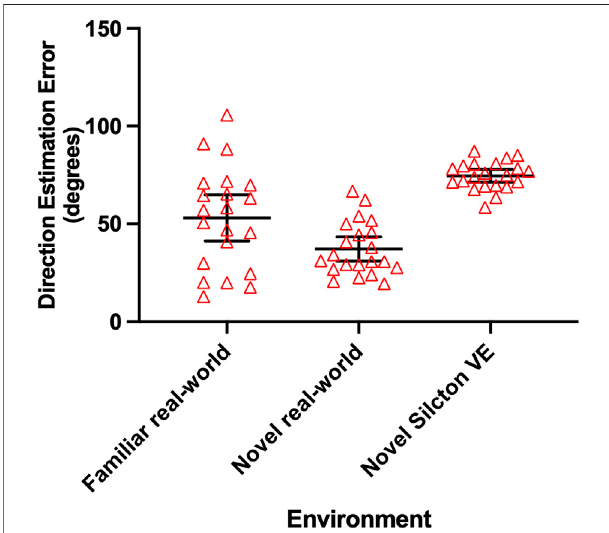
FIGURE 5 | Direction estimation error in degrees for all participants across the three environments in Experiment 2. Centre lines show means and error lines indicated 95% con fi dence intervals. Triangles show individual scores within each condition. Horizontal scatter of the scores corresponds to the number of scores at that value (wider = more scores).